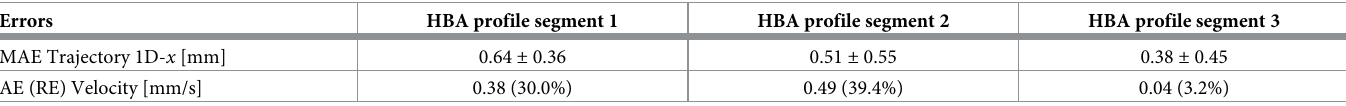
Table 3. The mean absolute error for the distance in x -direction with its standard deviation (SD) is presented for the HBA profile. The absolute and relative error of the velocity using the 3D regression line between t M 1 and t M 2 is also reported.